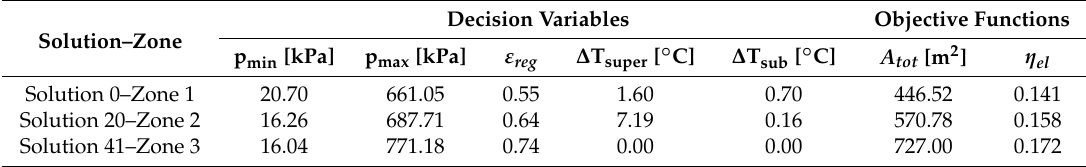
Table 6. Characteristics of three solutions belonging to the three zones identified in Figure 13.